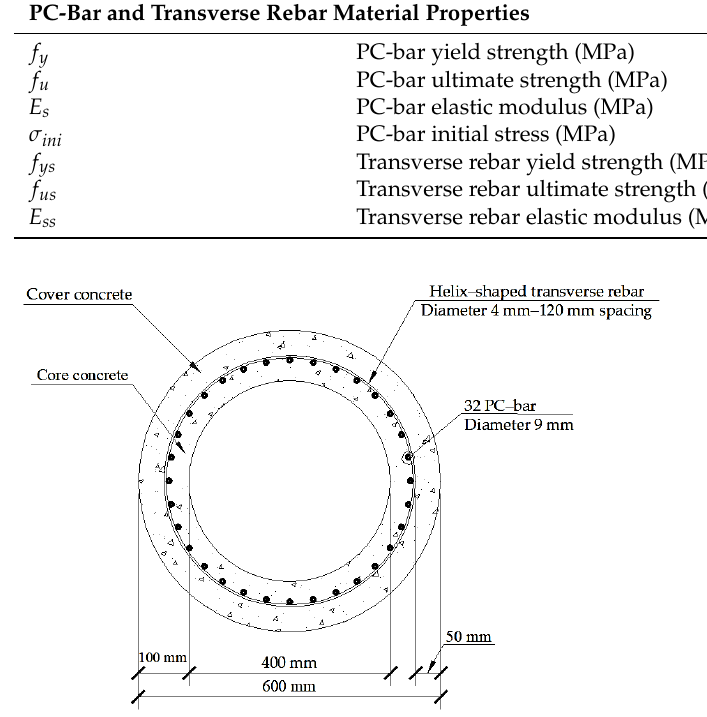
Figure 1. Spun pile dimensions.